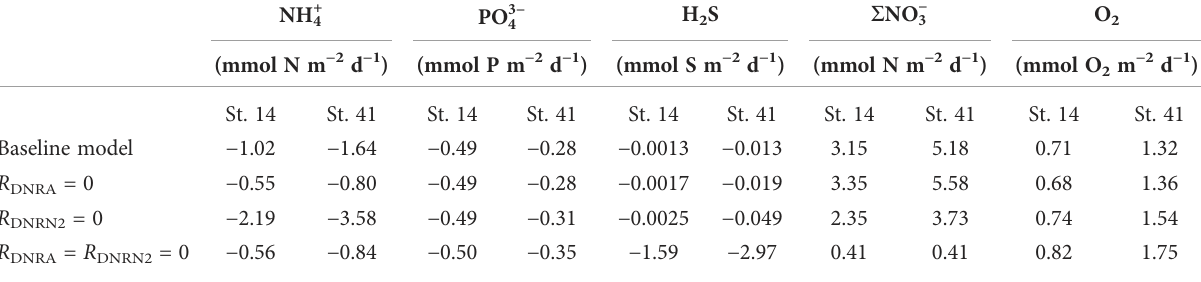
TABLE 3 Modeled benthic fl uxes for St. 14 and St. 41 derived from sensitivity analysis with and without sul fi de oxidation by LSB.